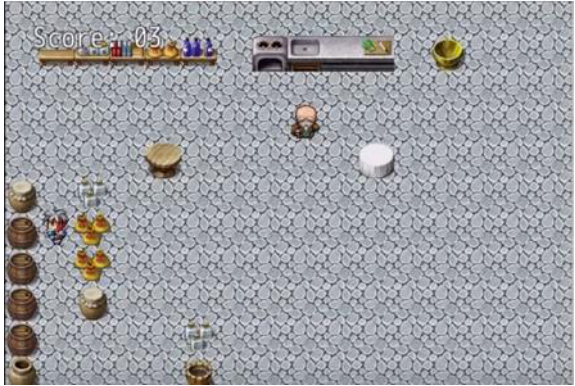
Figure 2. The lab: the wise man is waiting for the VC to select three mixtures which are hidden in the lab.